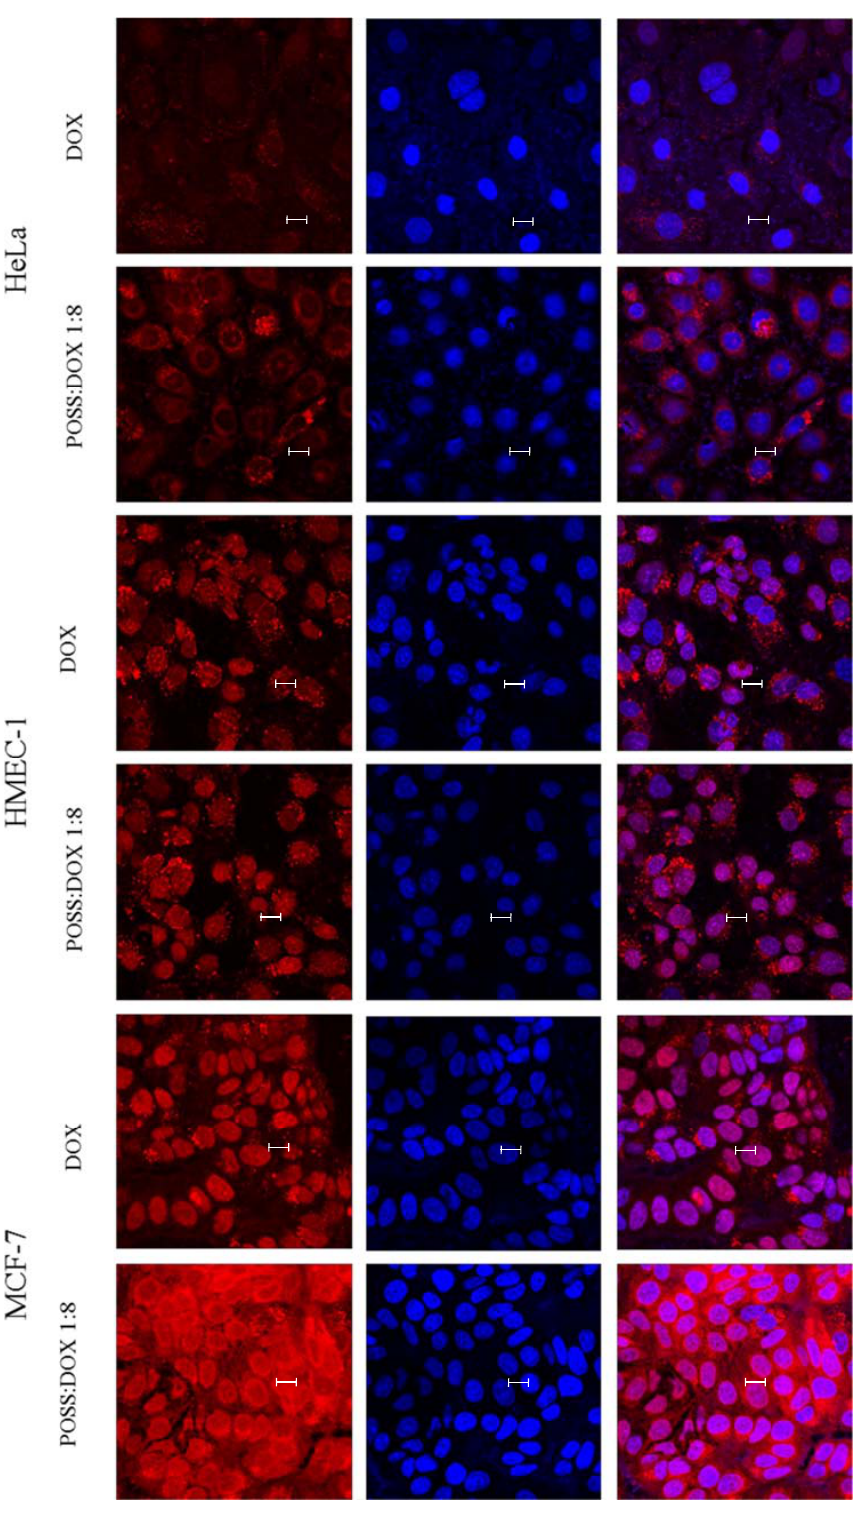
Figure 4. Confocal images of MCF-7, HMEC-1 and HeLa cells treated with 1 µ M doxorubicin or doxorubicin (1 µ M) co-delivered and polyhedral oligomeric silsesquioxane at POSS:DOX = 1:8 molar ratio. Doxorubicin (red channel), cell nucleus stained with DAPI (blue channel), and overlapping channels. Scale bars: 10 µ m.